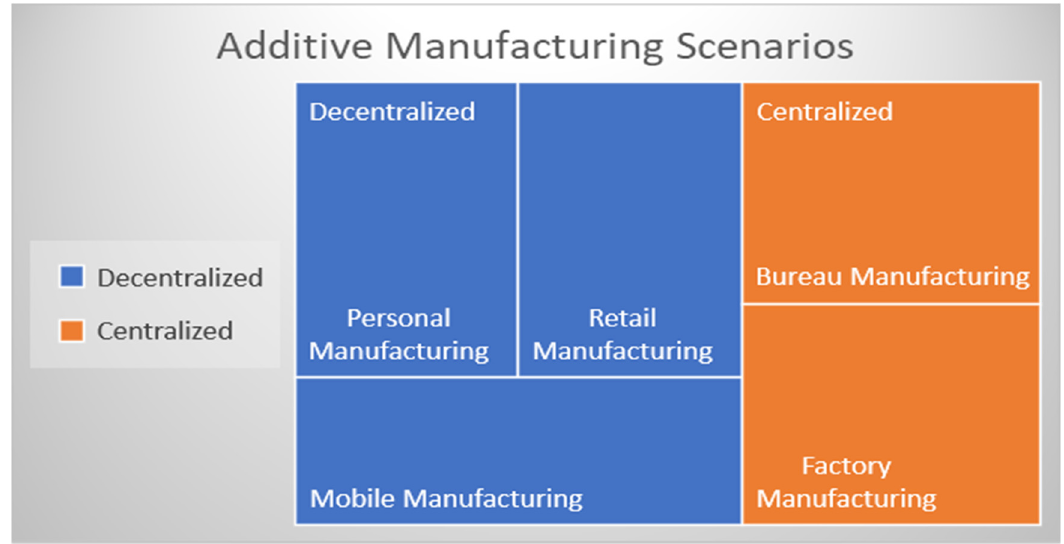
Figure 6. Different Scenarios of Centralized and Decentralized Additive Manufacturing.